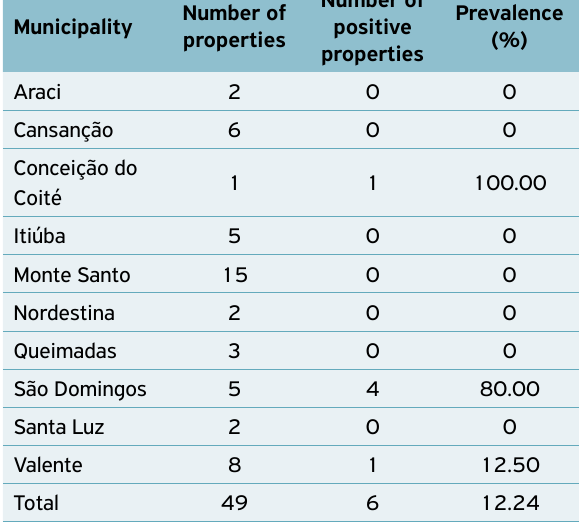
survey of goat arthritis encephalitis, in sisal territory, Bahia, Brazil, via agar gel immunodiffusion (AGID)